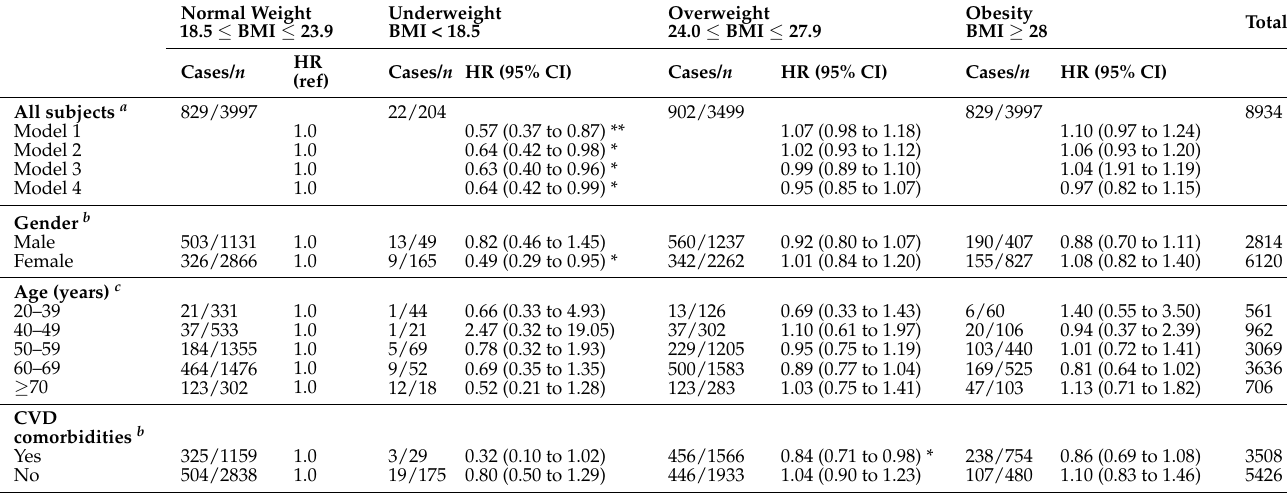
Table 2. Hazard ratios (HRs) and 95% confidence intervals (CIs) of HHcy according to Body Mass Index (BMI). Normal Weight Underweight 18.5 ≤ BMI ≤ 23.9 BMI < 18.5